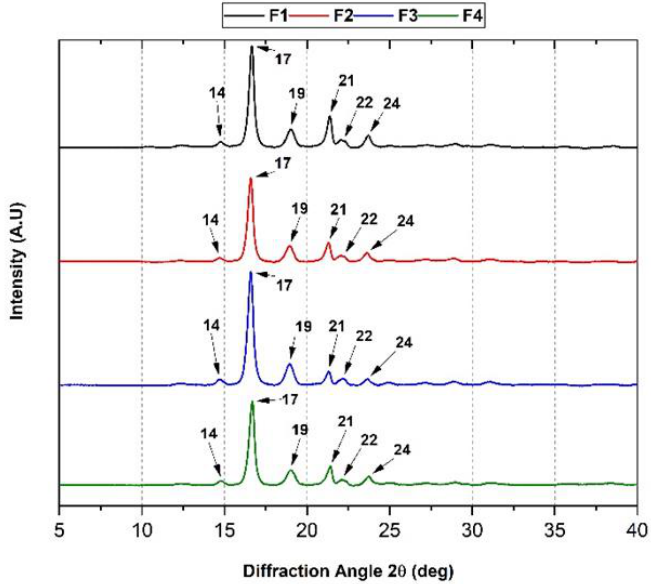
Figure 3. XRD analysis of the four membranes (F1 – F4 according to Table 1). F1, 30% PCL/70% PLA; F2, 27% PCL/70% PLA/3% TiO 2 ; F3, 20% PCL:70% PLA:10% OEO; F4, 17% PCL:70% PLA:3% TiO 2 :10% OEO.